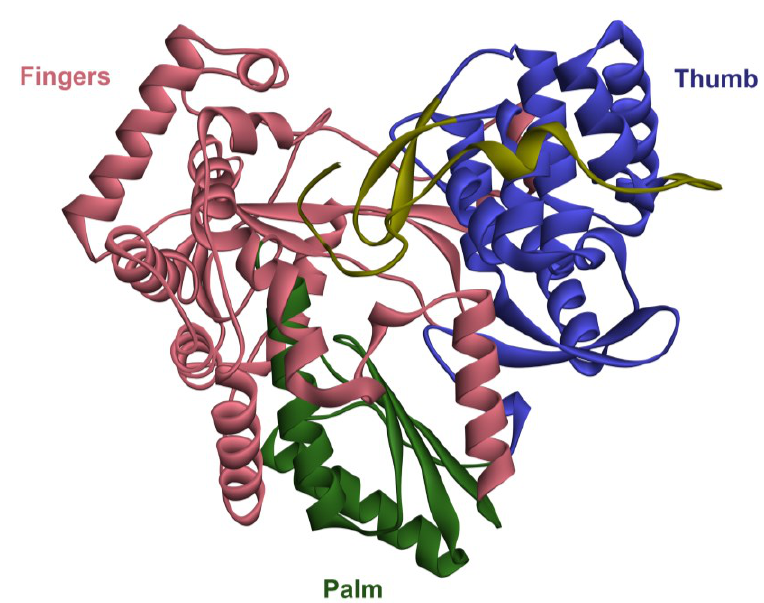
Figure 1. Crystal structure of the hepatitis C virus (HCV) RNA-dependent RNA polymerase (RdRp). The secondary structure of the HCV GT1b polymerase (Protein Data Bank (PDB) accession number 3FQL) is shown. The enzyme has a typical RdRp “right hand” structure with fingers (red) and thumb (blue) subdomains encircling the active site within the palm subdomain (green). The enzyme is typically crystallised in the shown “closed” conformation, thought to be associated with de novo RdRp activity, with the β-hairpin from the thumb domain and the C-terminal “linker” shown in yellow extending into the palm domain of the RdRp.